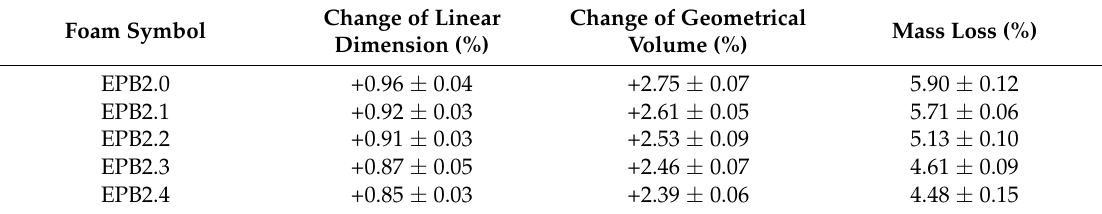
Table 7. Results of accelerated aging tests.